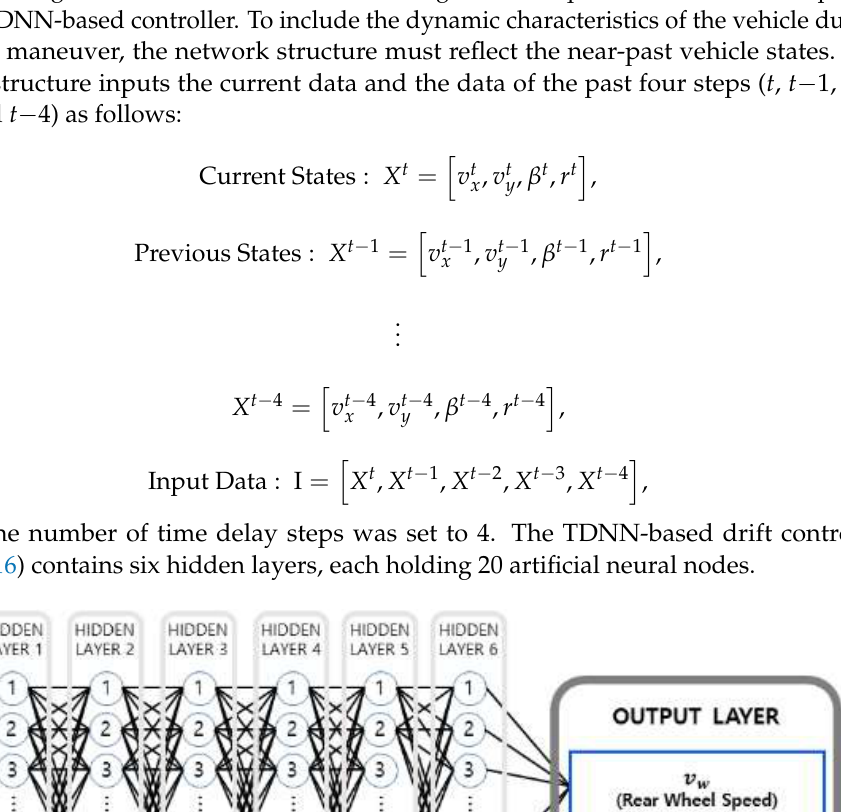
Figure 15. Deep neural network architecture for lateral positioning control.